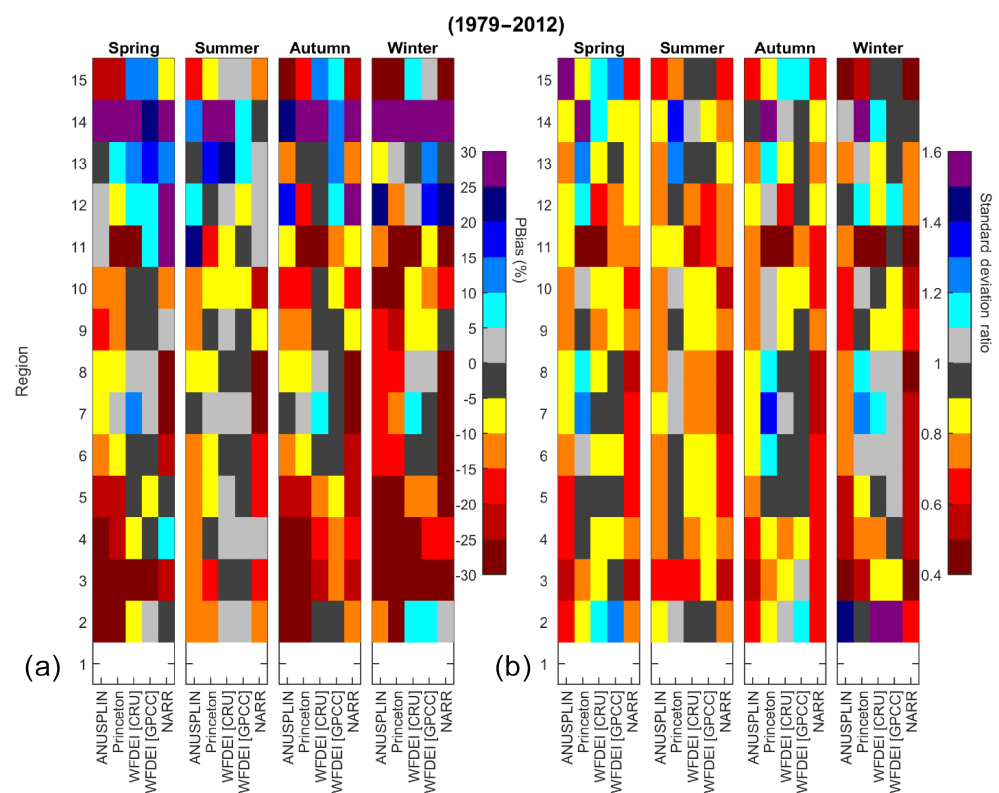
Figure 6. Portrait diagram showing the accuracy ( P Bias ) (a) and amplitude of the variations ( σ G /σ R ) (b) of each type of gridded precipi- tation products when evaluating against the precipitation-gauge station data in each ecozone (regions 1 to 15) in four seasons for the time period of 1979 to 2012. Each column indicates one gridded precipitation product and each row represents one ecozone with numerical code corresponding to region shown in Fig. 1. White indicates that no data are available due to no precipitation-gauge stations existing in that